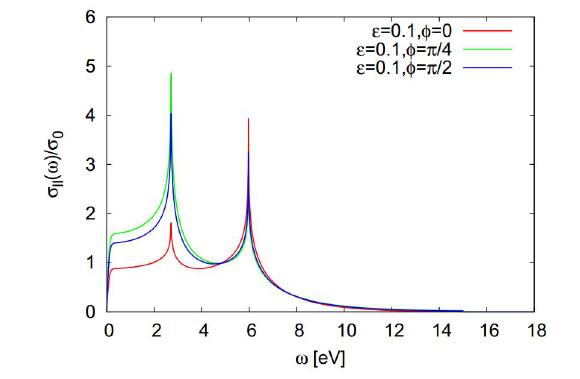
Figure 8. Similar to Figure 6, but the applied strain direction is θ = π /6. Reprinted with permission from [38]. Copyright (2010) American Physical